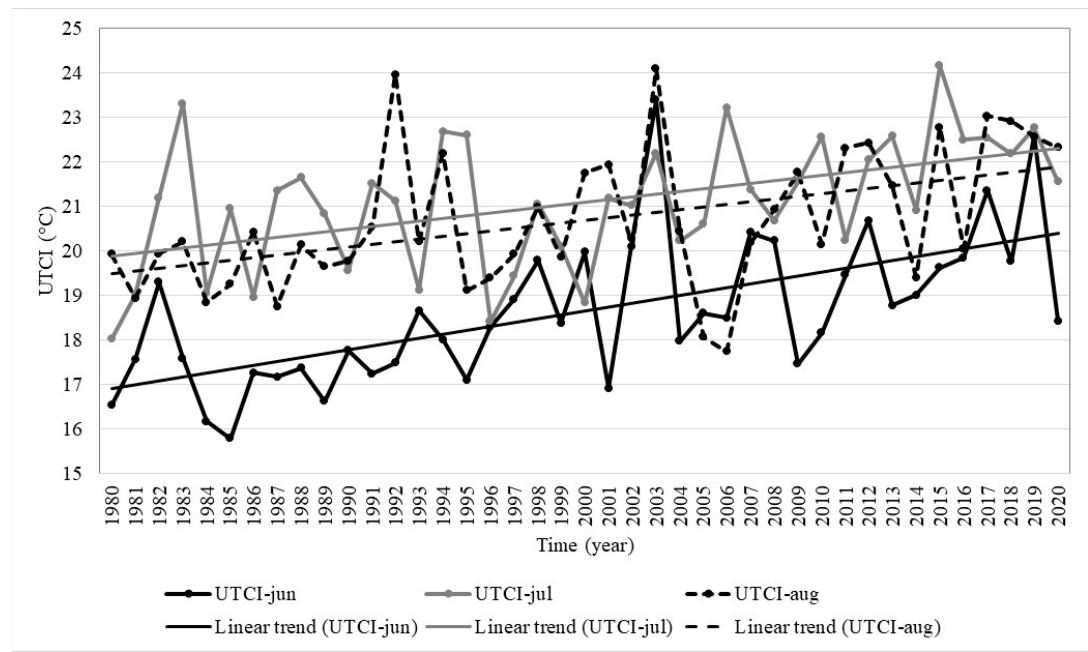
Figure 3. Average Universal Thermal Climate Index (UTCI) for June, July, and August in the period 1980–2020 for eastern Slovenia.